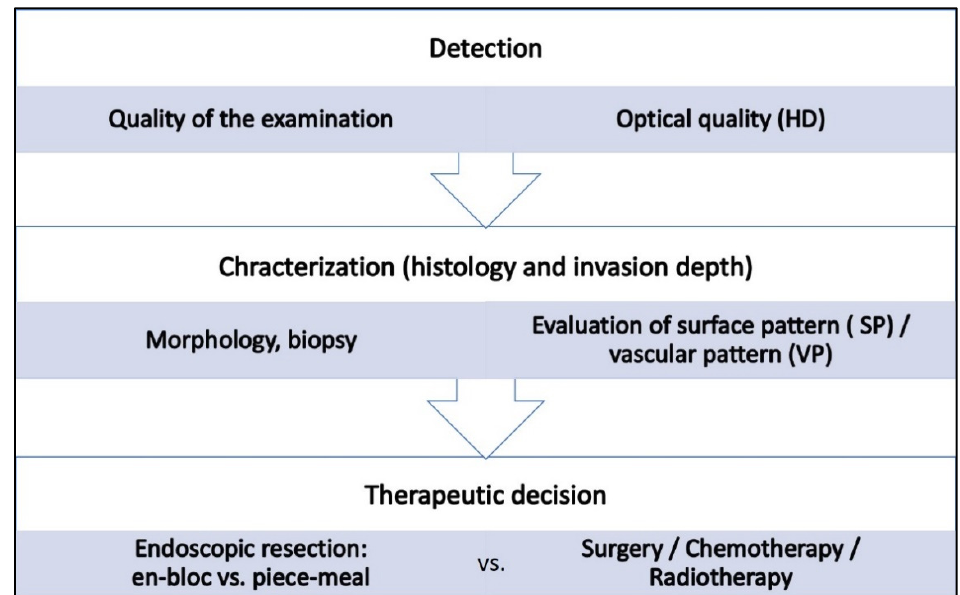
Figure 1. The steps of the diagnostic process in endoscopy, the according key issues and their impact on therapeutic decisions.